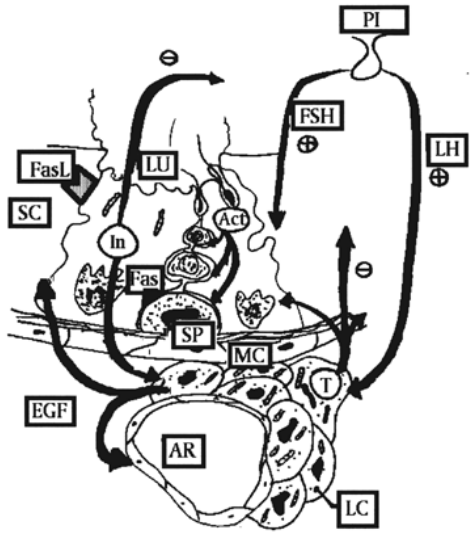
FIGURE 3. Endocrine regulation of